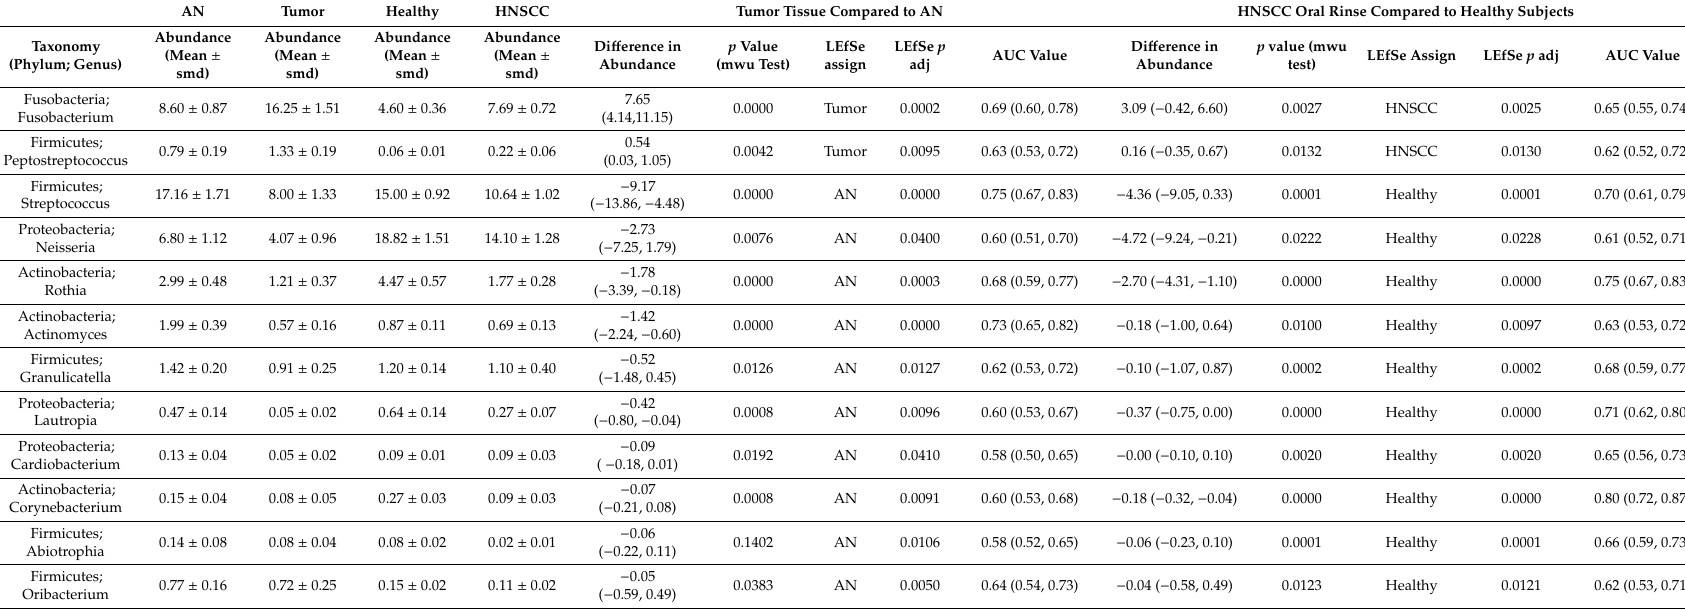
Table 1. Bacterial genera with coherent changes of the relative abundance between HNSCCs and controls across both tissues and oral rinses. AN Tumor Healthy HNSCC TumorTissueComparedtoAN